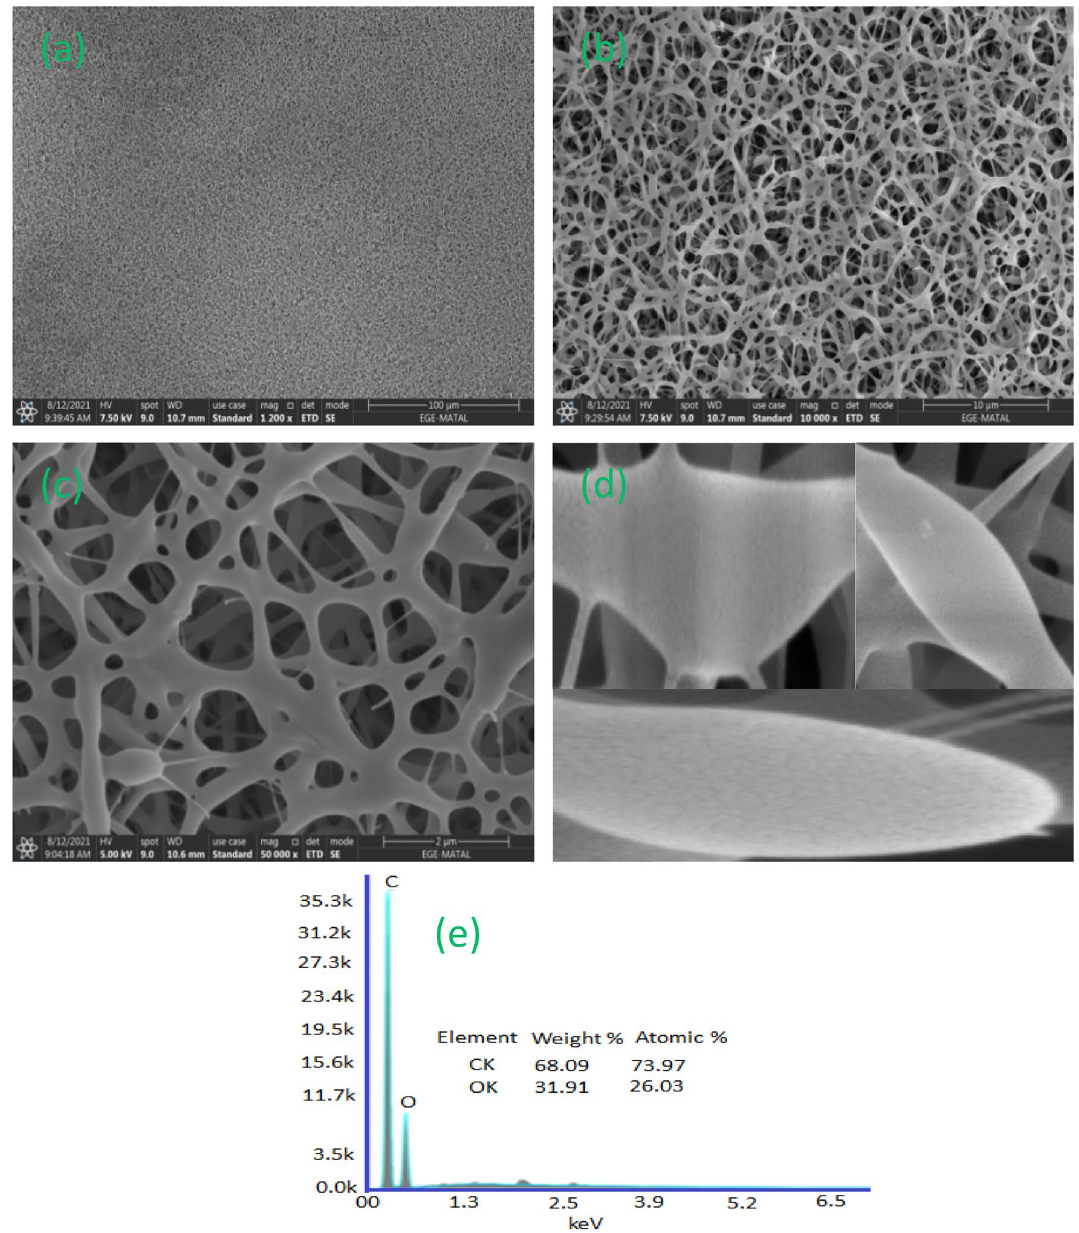
Figure 10. ( a – c ) SEM images of PVA, PVA: CNPs, PVA: CNPs: TLE after PM capture experiment, ( d ) SEM shows PM particles formed around the PVA: PVA: CNPs: TLE nanofilter, ( e ) EDX of PVA: PVA: CNPs: TLE after PM